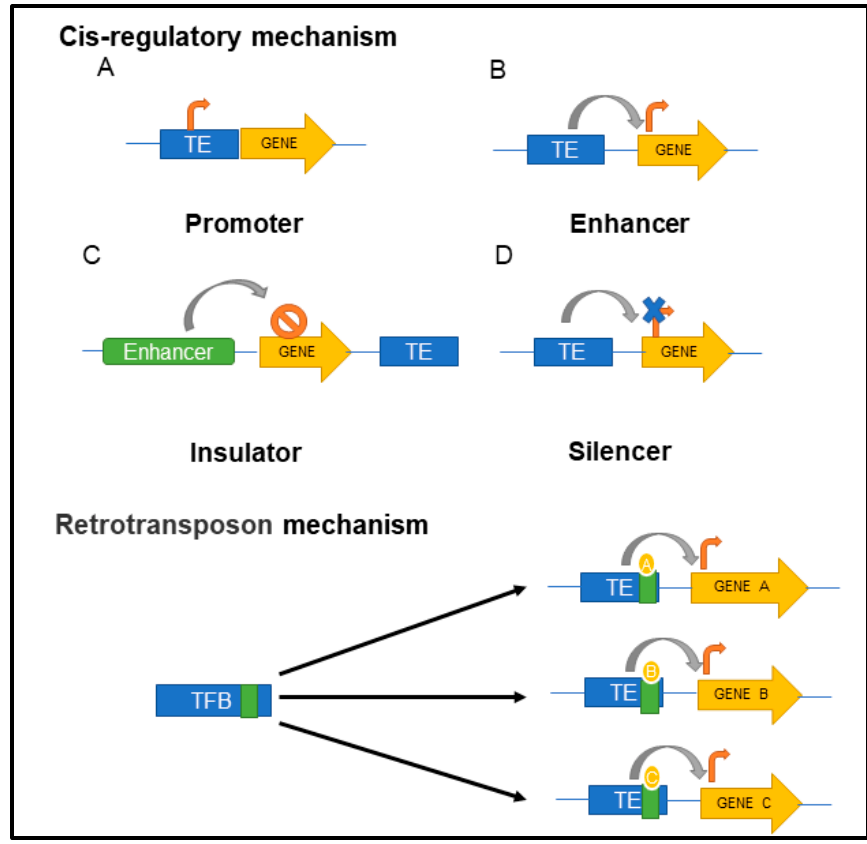
Figure 2. TE ‐ regulated mechanisms of action in the host cells. (1) Cis ‐ regulatory mechanisms involving ( A ) promoter and ( B ) enhancer, integrate the activity of specific transcription factor; ( C ) insulator, act either through enhancer ‐ blocking activity or chromatin barrier activity; ( D ) silencer, silence the expression of genes. (2) Retrotransposon mechanism can increase the potential of transcription binding factor. (orange arrowhead indicates increased activity, blue cross indicates silencing of activity, circle with single cross indicates insulation of gene activity, grey arrow indicates direction of